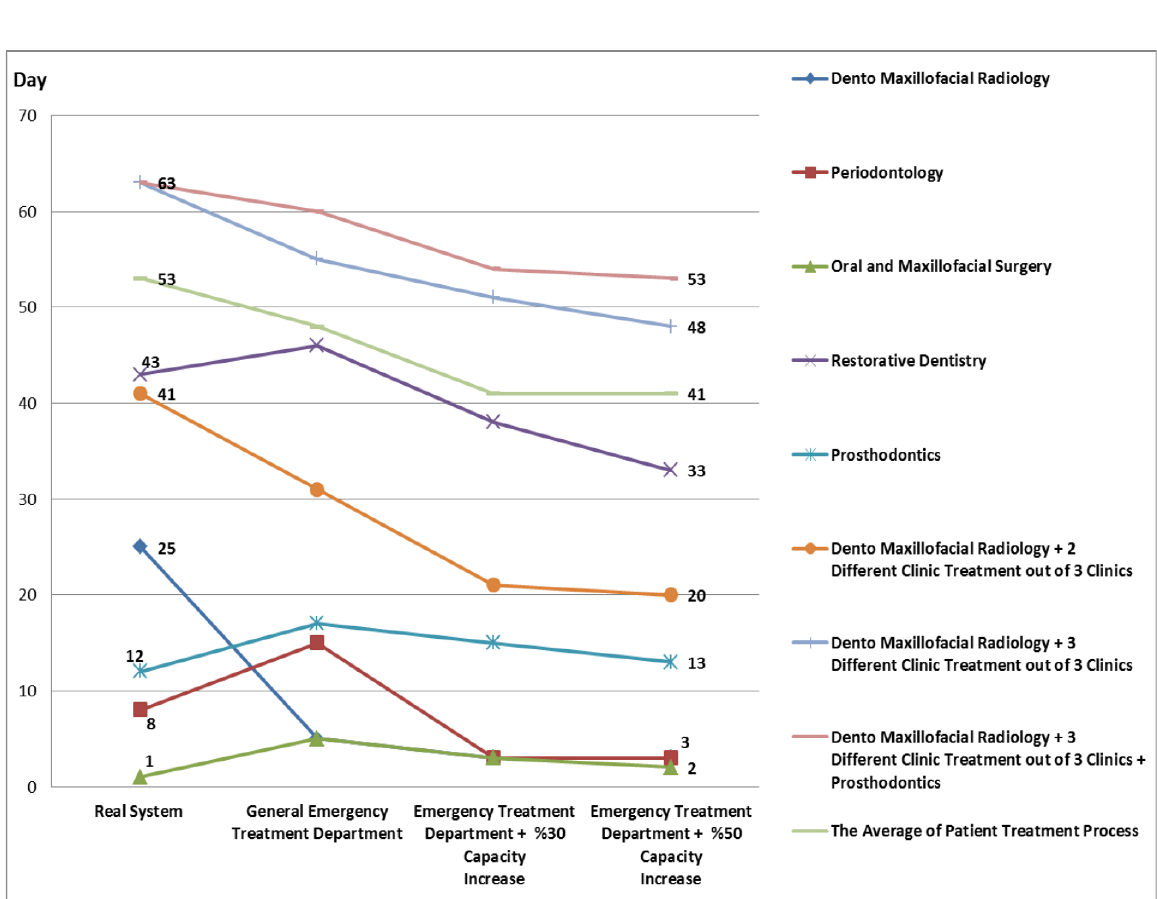
Figure 11. The impact of different alternative senarios for patient treatment